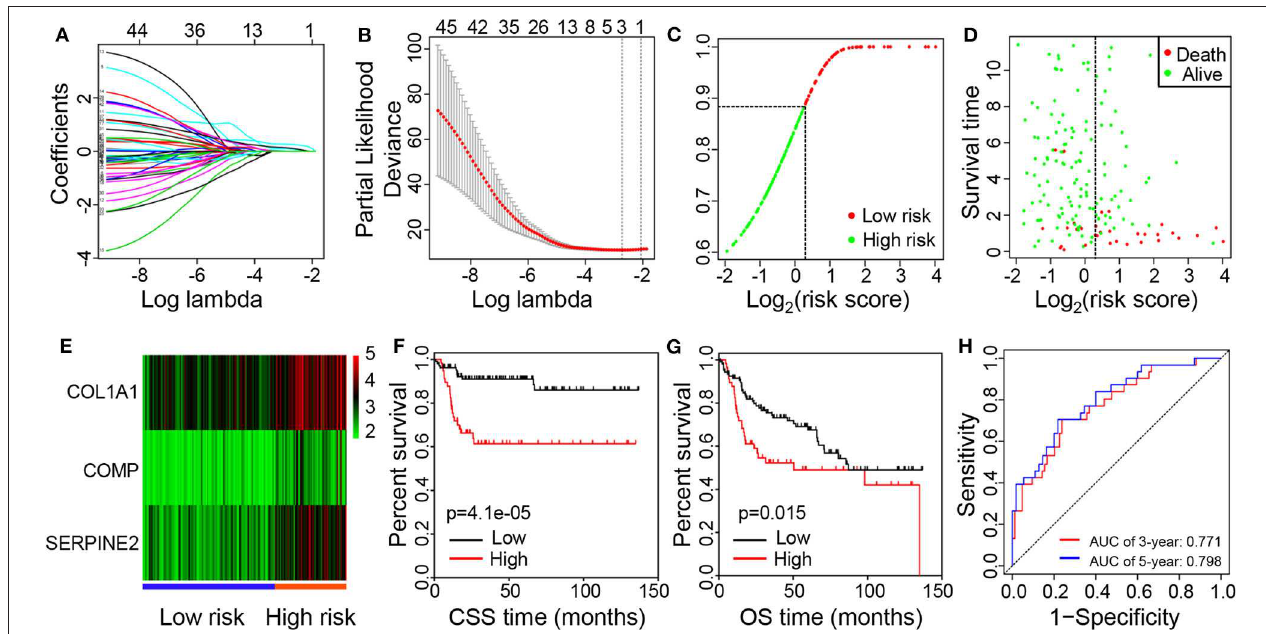
FIGURE 4 | Identification of prognostic genes and establishment of the risk prediction model. (A) LASSO coefficient profiles of the 45 significant genes from the result of the univariate regression. (B) Feature selection for prognostic biomarkers using the LASSO method. (C) Distributions of risk score. (D) The survival time of patients in high- and low-risk groups. (E) Heat map of expression levels of the three prognostic genes in the high- and low-risk groups. (F) Kaplan–Meier curves of CSS for patients with low vs. high risk scores. (G) Kaplan–Meier curves of OS for patients with low vs. high risk scores. (H) ROC curves of the risk model for predicting 3- and 5-year survival rates. LASSO, Least Absolute Shrinkage and Selector Operation; CSS, cancer-specific survival; OS, overall survival; ROC, receiver operating